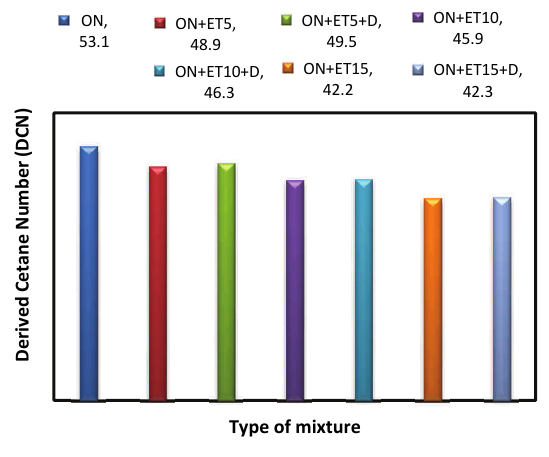
Fig. 4. DCN value for the blends tested